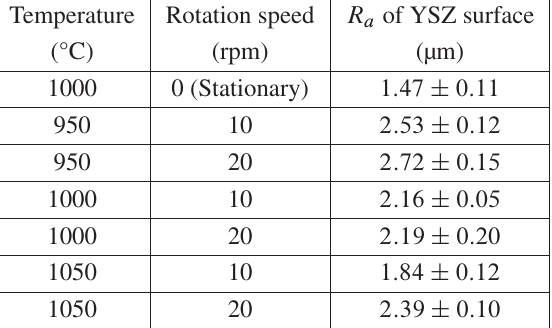
Table 1. Processing conditions for deposition of 7YSZ layer and the corresponding surface roughness .R a / val-